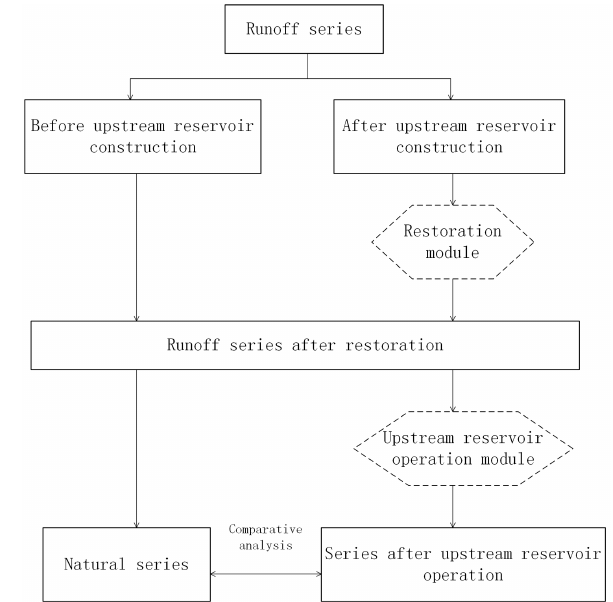
Figure 2. Runoff impact model calculation process.